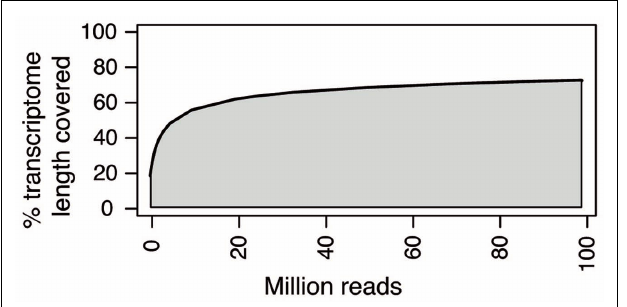
FIGURE 2 | Percentage of transcriptome covered versus number of RNA-seq reads used. Eighty-one base pair paired-end RNA-seq reads from S. lycopersicum were randomly sampled in different subset sizes and aligned to the S. lycopersicum genome reference.The percentage of the length of the transcriptome covered by at least one read is represented at different